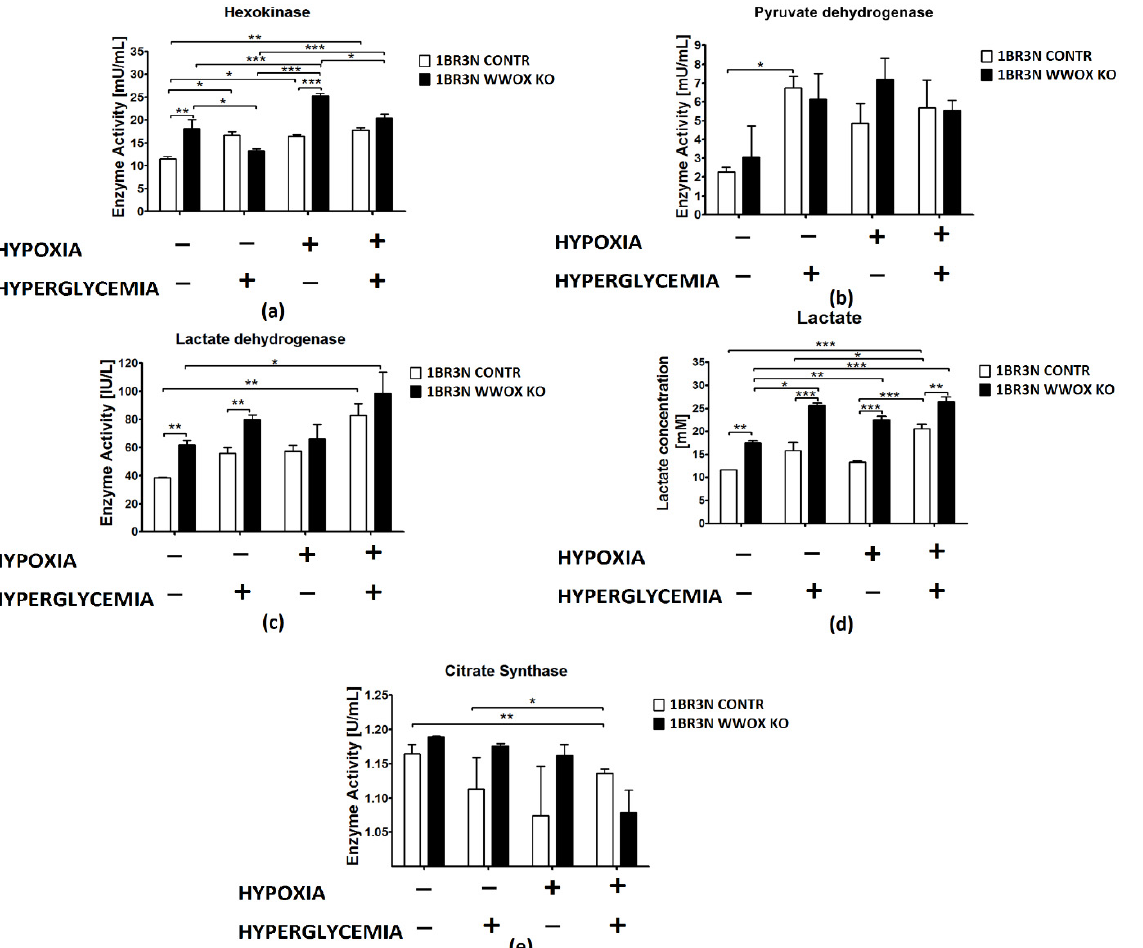
Figure 5 . Colorimetric method study of aerobic glycolysis metabolic enzymes and metabolites in 1BR.3.N CONTR and WWOX KO cells after 48 h incubation in four tested condition. Bar graphs showing the enzyme activity of Hexokinase ( a ), Pyruvate Dehydrogenase ( b ), Lactate Dehydrogenase ( c ) Citrate Synthase ( e ) and Lactate concentration ( d ). Results of ANOVA with a post-hoc Tukey-Test are shown as mean ± SEM. *, p < 0.05; **, p < 0.01; ***, p < 0.001.